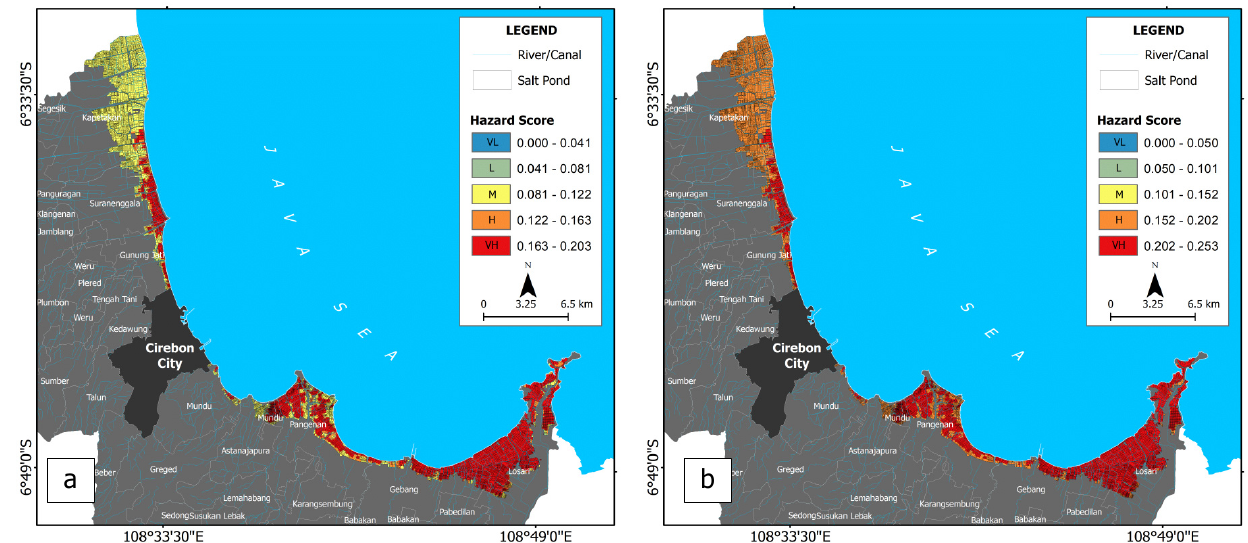
Figure 5. Hazard scores due to tidal flooding during the 2016 ( a ) and the 2018 ( b ) events.